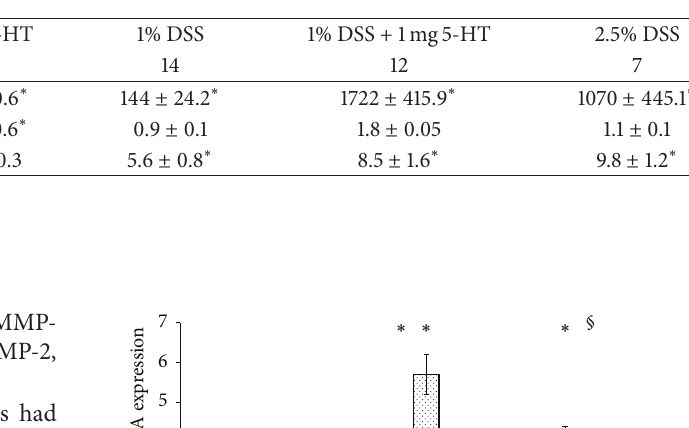
Table 3: 5-HT increases cytokine gene expression in mouse colon.